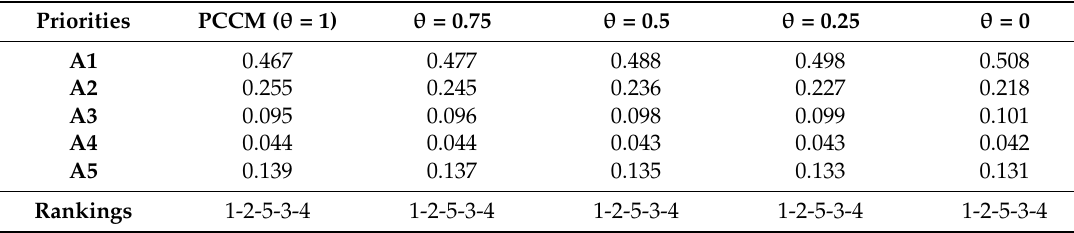
Table 11. Priority vectors and rankings for the modified PCCMs with different values of 